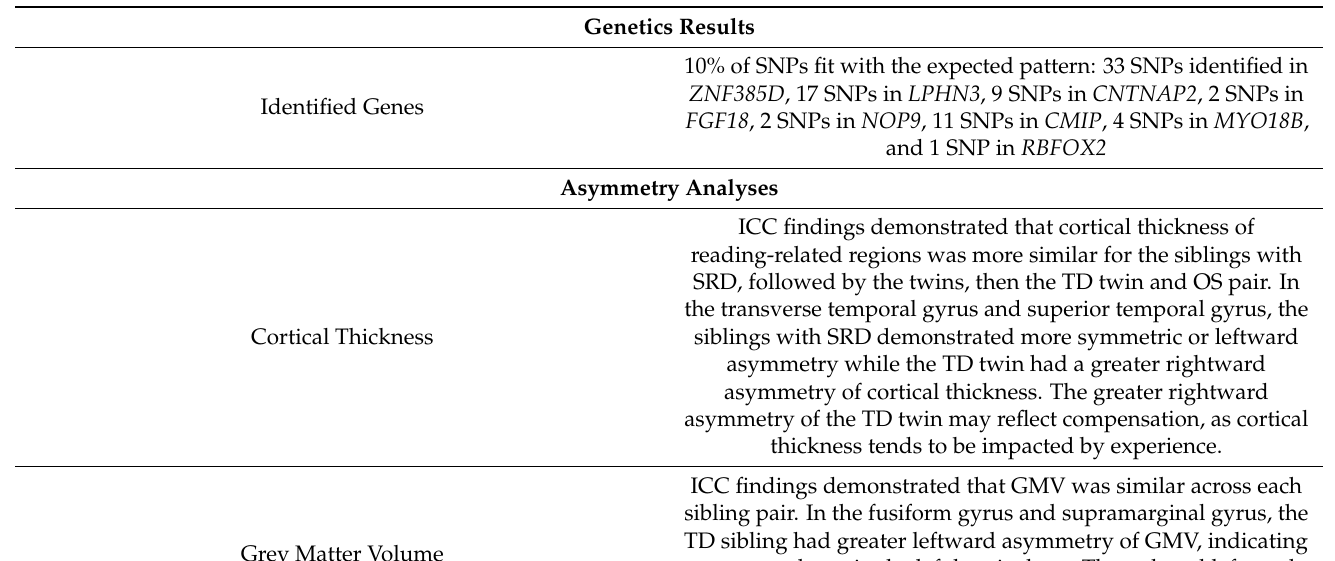
Table 4. Summary of primary